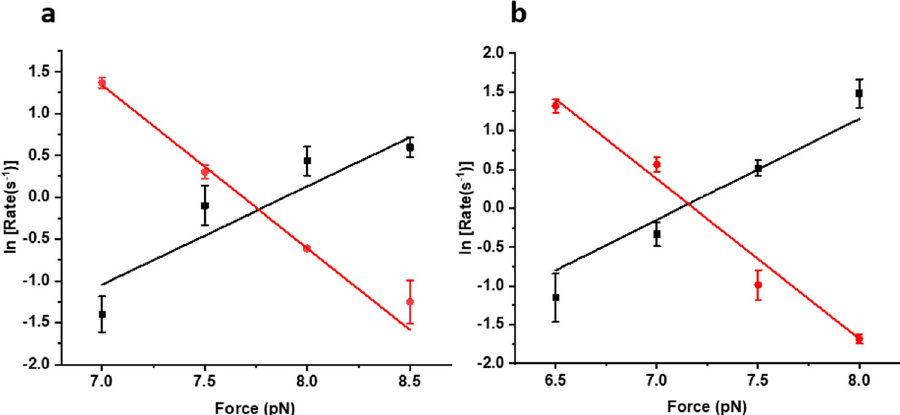
Fig. 6 Talin kinetics with Hsp40 and Hsp70. The unfolding and refolding kinetics are plotted as a function of force, in the presence of Hsp40 and Hsp70. Unfolding rate increases and refolding rate decreases with the force and the cross-point of these two rates is de fi ned as intersection force. a The intersection force in the absence of any chaperones (control) is 9.7 pN, however, has been observed to shift to 7.8 pN with Hsp40. b Similarly, in the presence of Hsp70, the intersection force of talin is 7.2 pN. This certainly signi fi es that Hsp40 and Hsp70 decrease the mechanical stability in talin under force. Data points are calculated by an averaging minimum of three molecules per force. Error bars are the relative error of